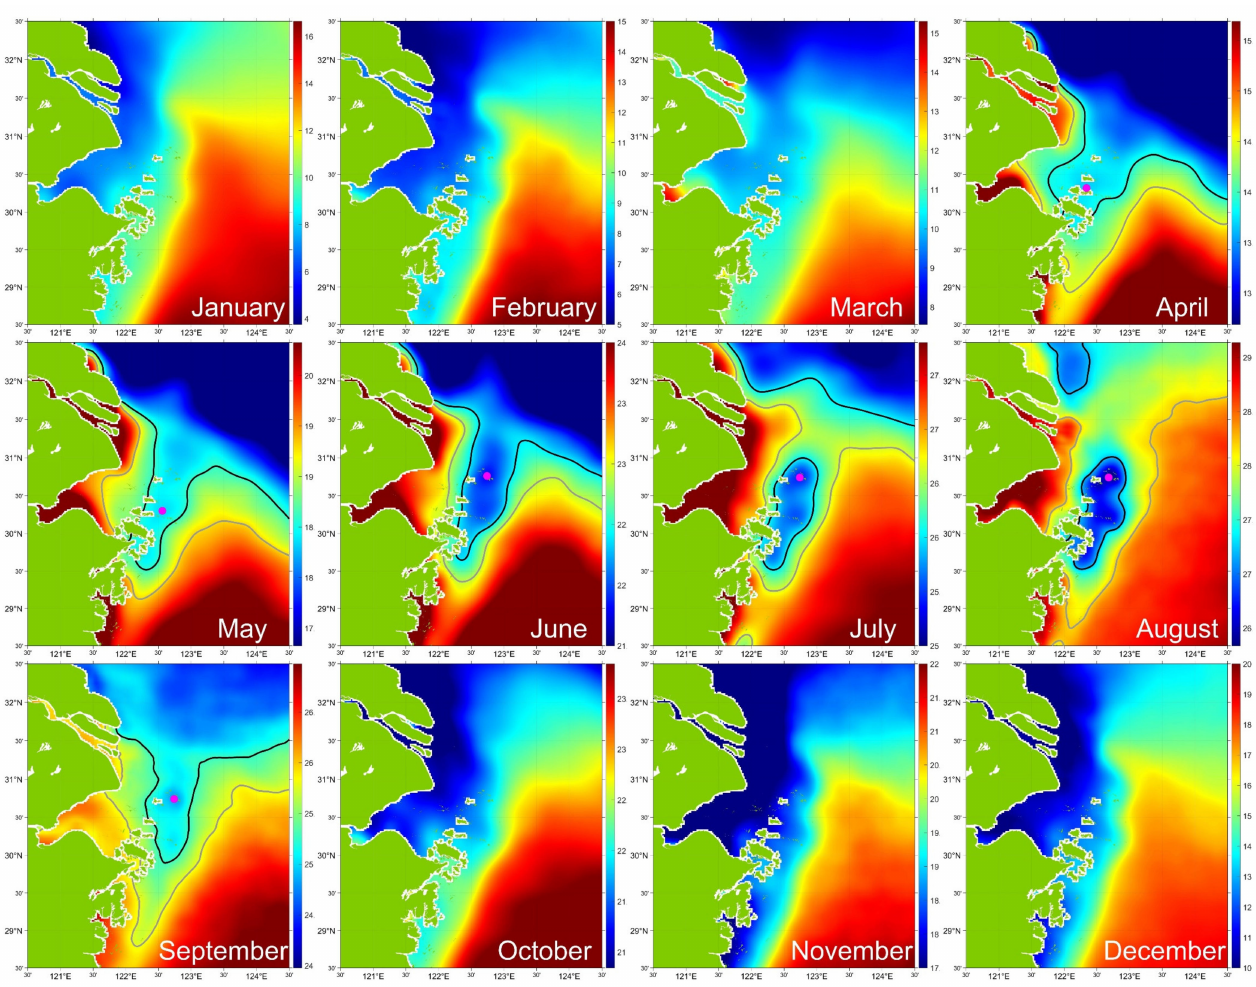
Figure 4. Monthly mean SST maps between July 2015 and December 2021. The magenta dot shows the location of upwelling center. The black line shows the boundary between the core area and mixed area. The gray line shows the boundary between the mixed area and surrounding